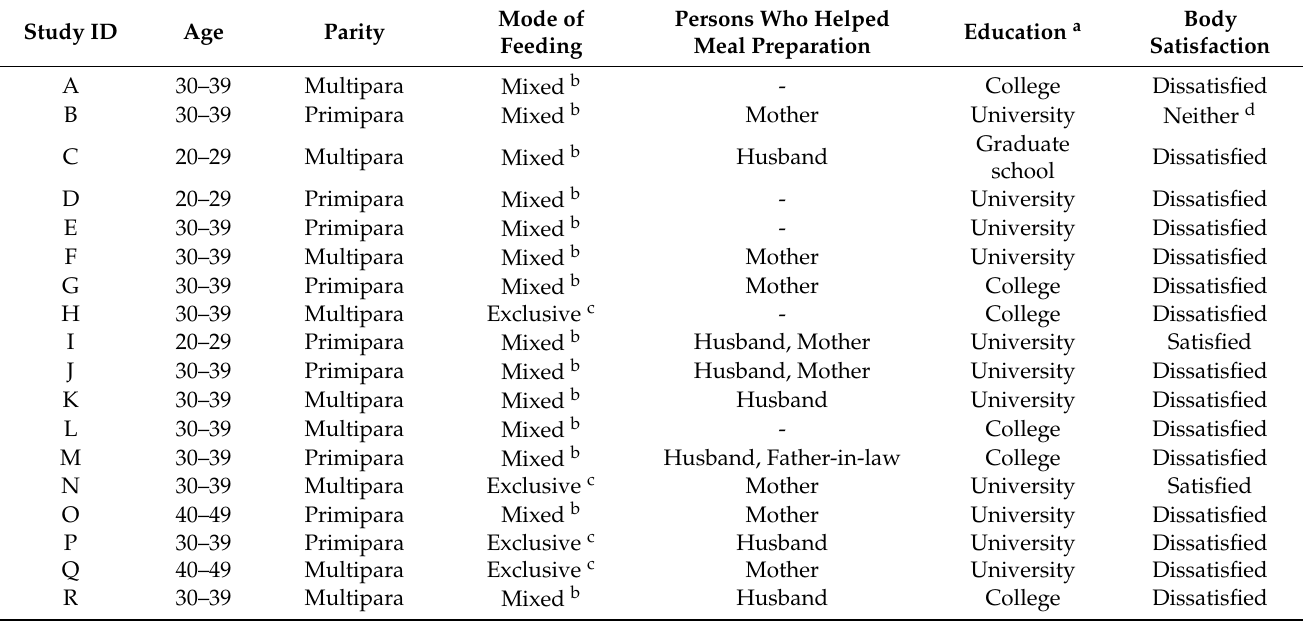
Table 1. Participants’ demographic information at one month postpartum.